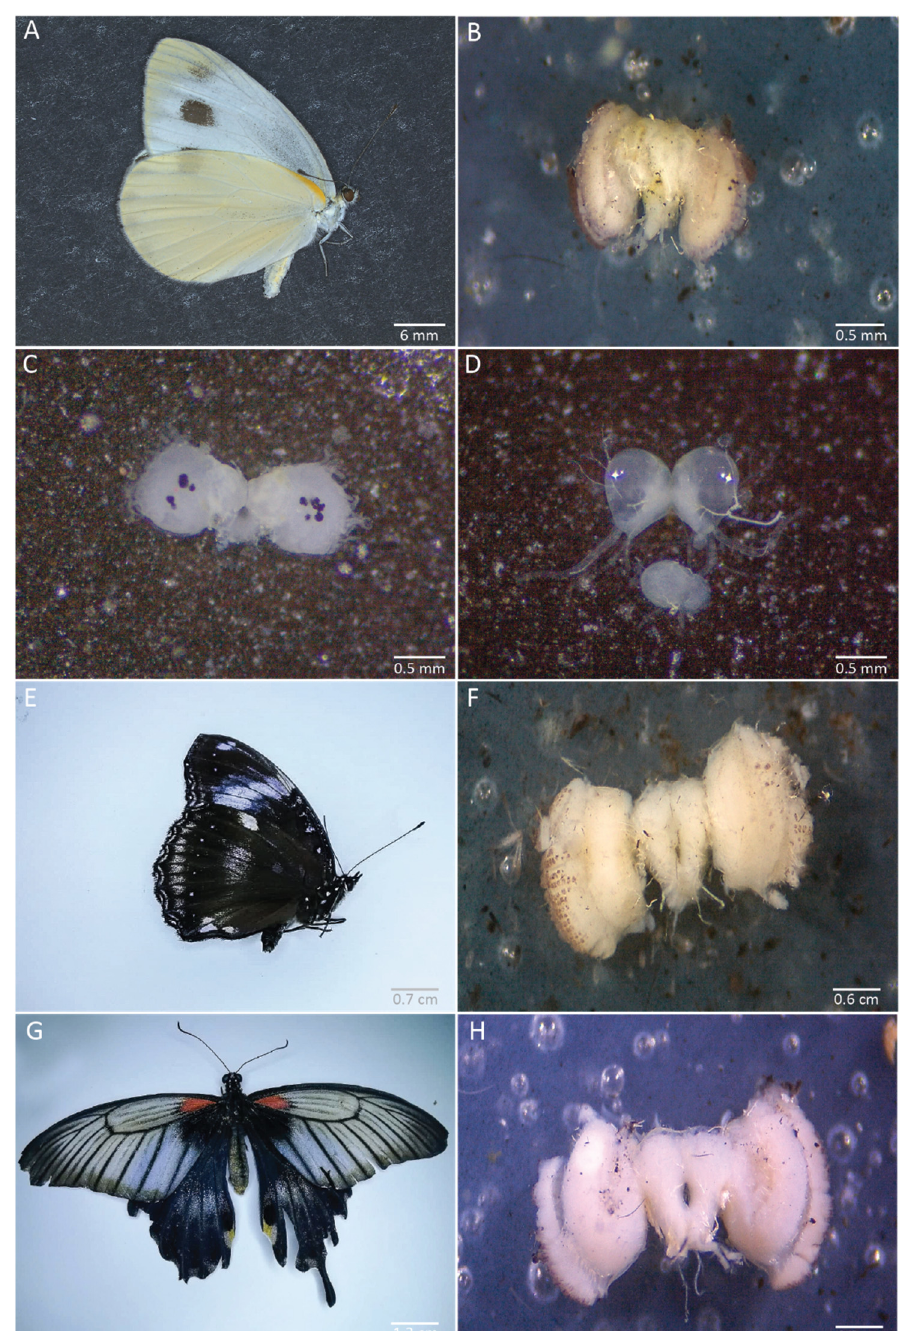
Figure 10. Brains dissected from Pieris canidia, Hypolimnas anomala, and Papilio sp. ( A – C ) Pieris canidia brain at the adult stage (fixed brain, B ), at 30% pupal development (not fixed, C ), and the 5th instar larval stage (not fixed, D ). ( F ) Adult brain from Hypolimnas anomala (Nymphalidae, E ). ( H ) Adult brain from Papilio sp (Papilionidae, G ).